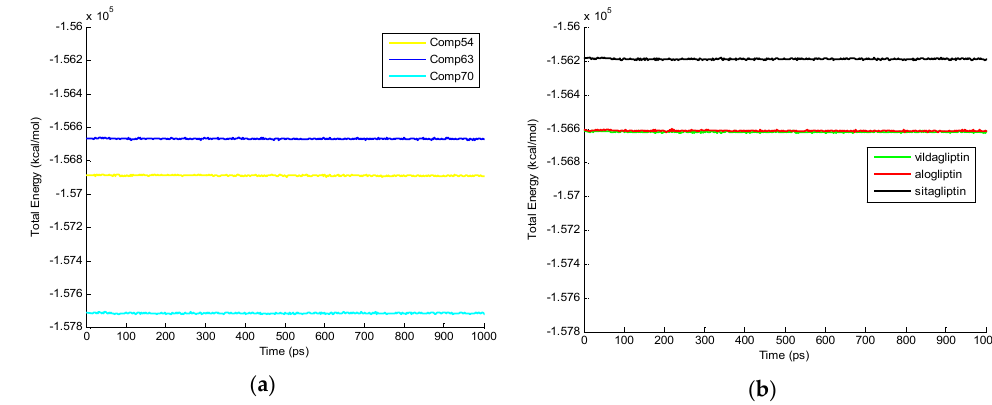
Figure 8. Total energies of protein-ligand complexes interaction during 1000 ps MD simulation. ( a ) Total energy of MD in complexes 2P8S_Comp54, 2P8S_Comp63, and 2P8S_Comp70 depicted as yellow, blue, and cyan plots, respectively; ( b ) Total energy of MD in complexes 2P8S_vildagliptin, 2P8S_alogliptin, and 2P8S_sitagliptin depicted as green, red, and black plots, respectively. Furthermore, Arg125, Glu205, Ser209, Arg358, Tyr547, Ser630, Tyr666, and His740 are the crucial amino acids (Figure 9) in formation of 12 H-bonding interactions with Comp70 during MD simulation. Amino acids Arg125, Arg358, Tyr547, and Ser630 are participating in both CDOCKER